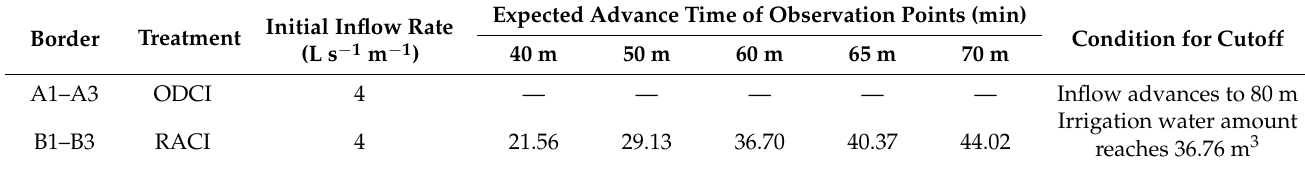
Table 2. Experimental treatment design of ODCI and